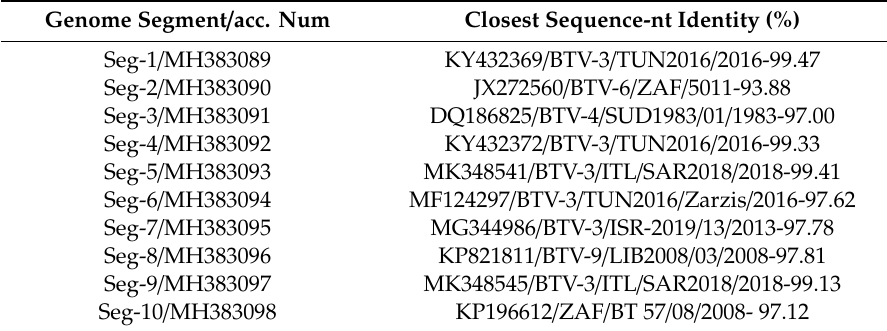
Table 6. Blast analysis of Israeli BTV-6 showing closest nucleotide and segment sequence identity with publically available BTV